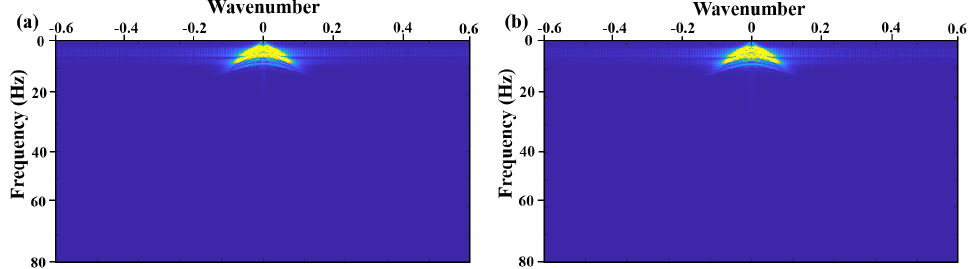
Figure 10. The ( a ) f-k spectra of the data in Figure 8a; ( b ) f-k spectra of the data in Figure